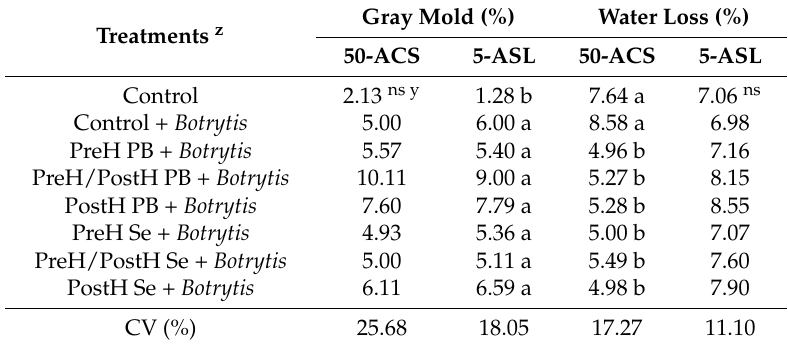
Table 3. Gray mold incidence and water loss in ‘BRS Isis’ seedless table grapes subjected to preharvest (PreH), pre- and postharvest (PreH/PostH), and postharvest (PostH) treatments at 50 days after cold storage (50-ACS) and at five days after shelf-life